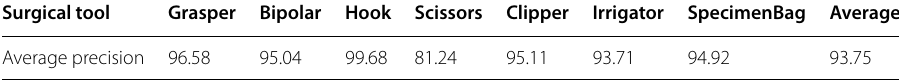
Table 1 Average precision (AP) for all tools, evaluated on Cholec80 dataset Surgical tool Average precision 96.58